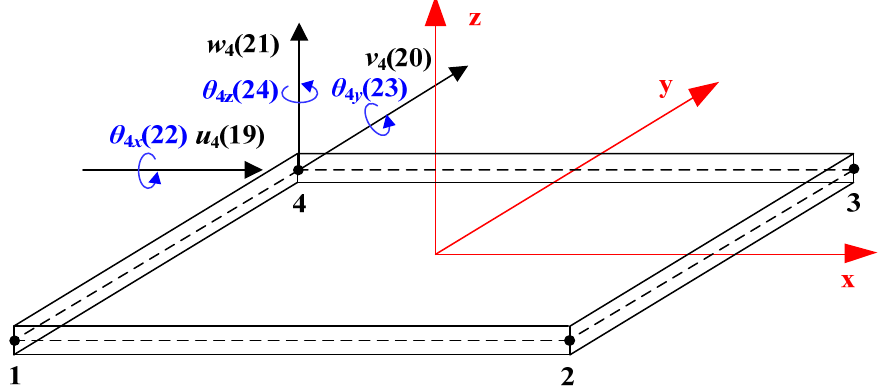
Figure 5. Node displacement and DOF number of the shell element.